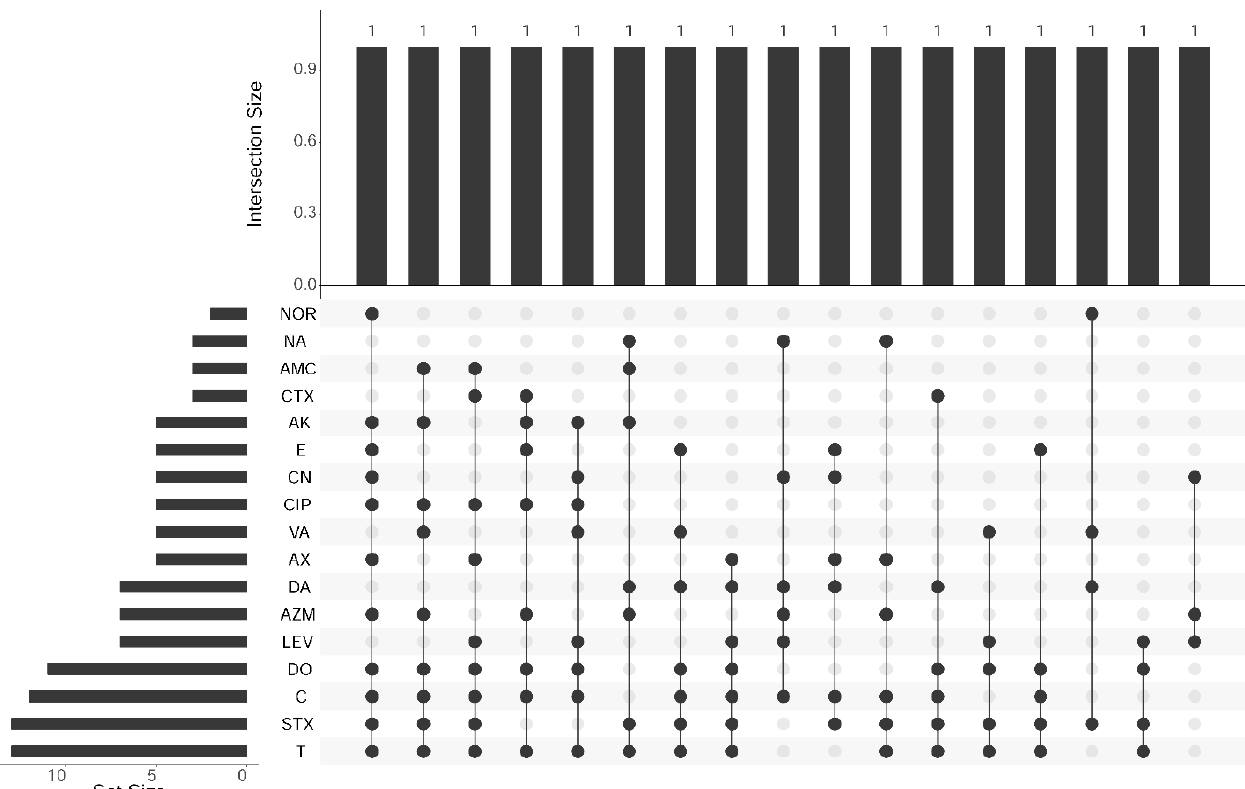
Figure 1. The multidrug-resistant profiling of L. monocytogenes isolates from food products. Note: amikacin (AK), ciprofloxacin (CIP), nalidixic acid (NA), chloramphenicol (C), doxycycline (DO), cefotaxime (CTX), trimethoprim- sulfamethoxazole (SXT), amoxicillin/nalidixic acid (AMC), levofloxacin (LEV), norfloxacin (NOR), azithromycin (AZM), danofloxacin (DA), oxytetracycline (T), erythromycin (E), gentamicin (CN), vancomycin (VA) and amoxicillin (AX).